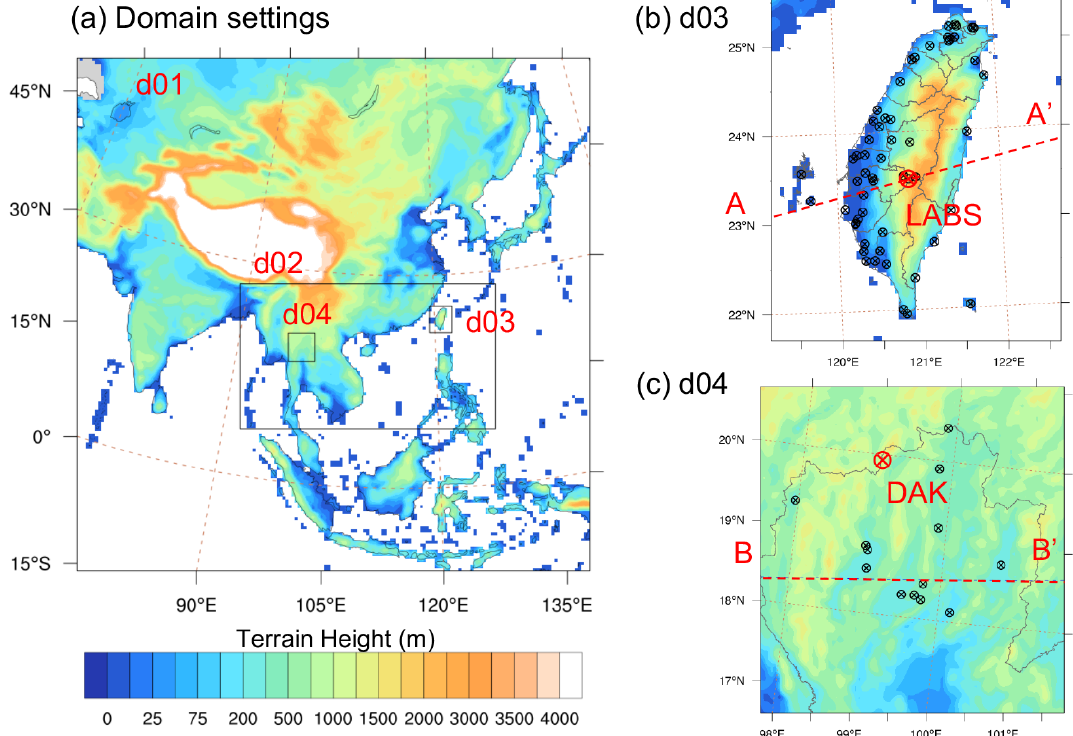
Figure 1. (a) Domain setup of model (domain 1–4) with terrain height information; (b) third domain covering Taiwan (d03) with information of terrain height (contour fill), AA’ cross-section (dotted red line), and locations of Taiwan EPA air quality and CWB weather stations (black dots) and LABS receptor site (big red dot); (c) fourth domain covering part of nPSEA (d04) with terrain height (contour fill), BB’ cross- section (dotted red line), and location of Thailand PCD ground air quality stations (black dots) and the DAK source site (big red dot). The MPLNET data collected are located at the DAK station (big red